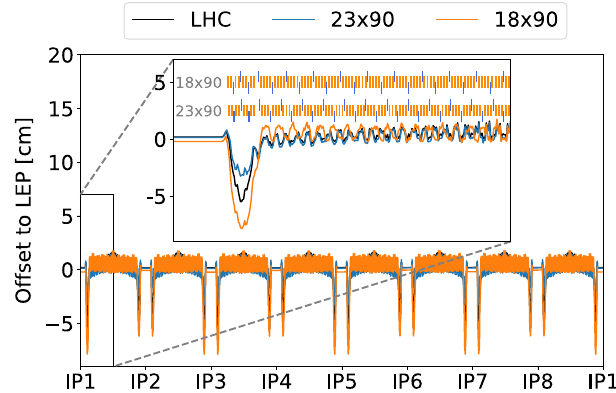
FIG. 16. Geometry offset of HE-LHC options and LHC with respect to LEP. Only the dispersion suppressors neighboring odd interaction regions include two TCLDs, as shown in Fig. 15 (bottom).